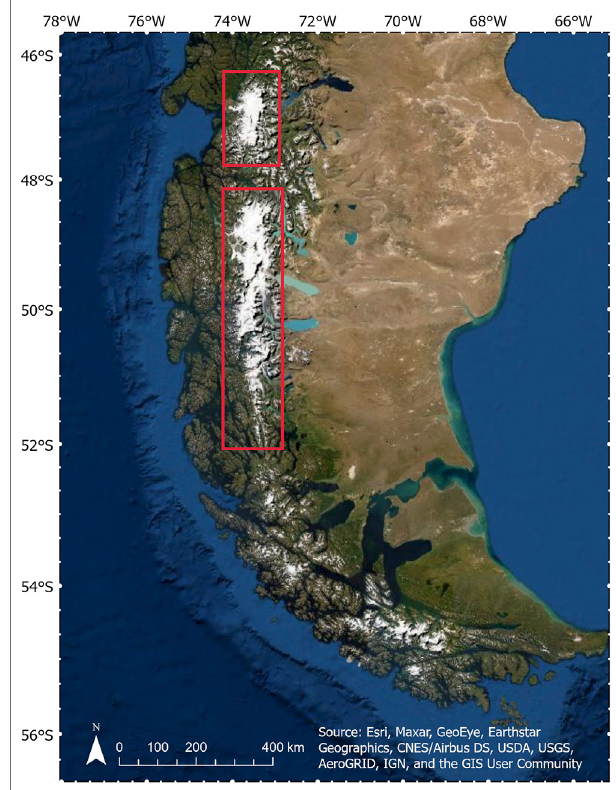
FIGURE 1 | Study area. Red boxes indicate the Northern Patagonian Ice fi eld (NPI) and the Southern Patagonian Ice fi eld (SPI).